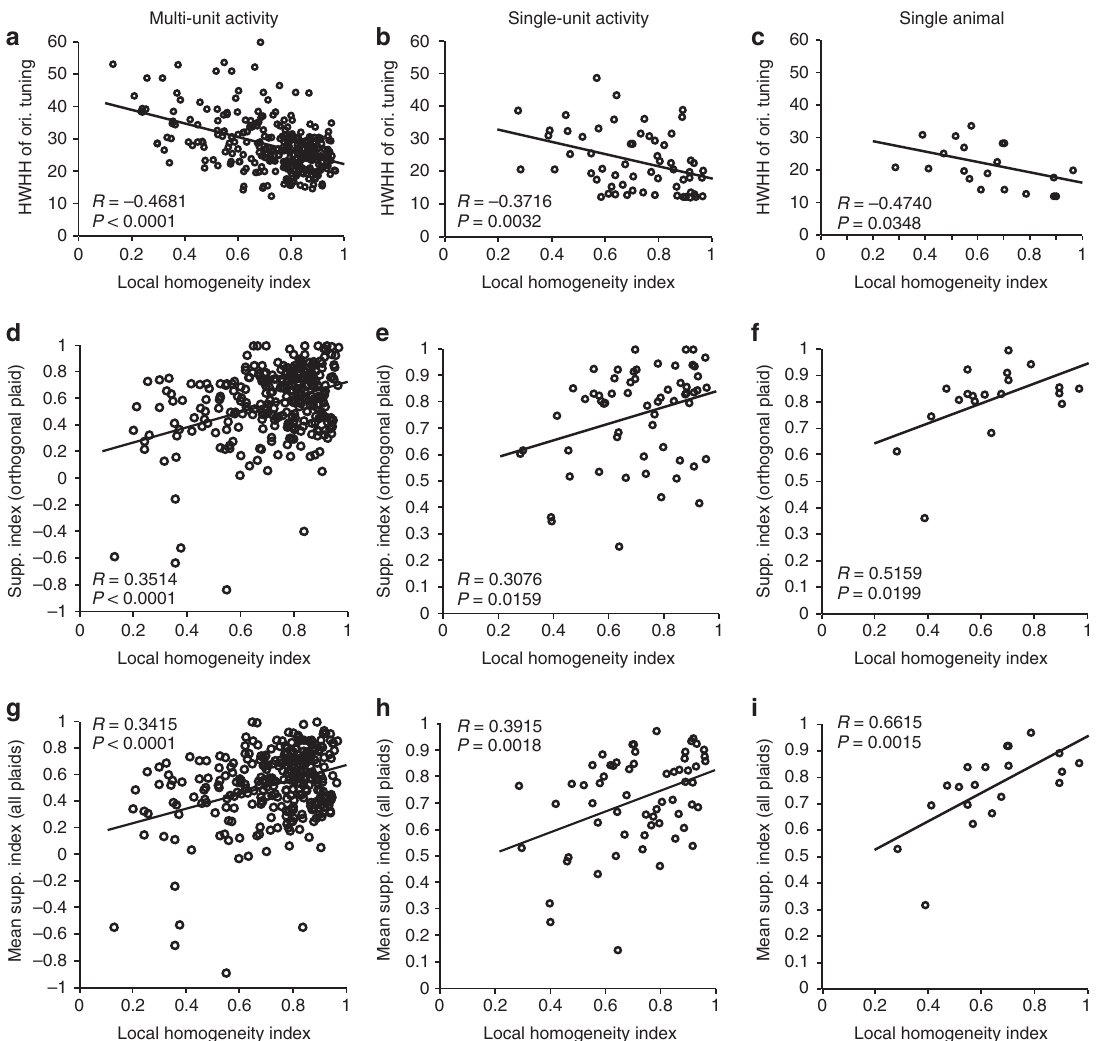
Figure 2 | Association between stimulus orientation and cortical orientation topography. Left column: multi-unit activity ( N ¼ 303; 6 cats). Middle column: single neuron activity ( N ¼ 61; 6 cats). Black lines depict best-fitting linear regression. Right column: single neuron activity for one cat ( N ¼ 20). ( a – c ) Orientation tuning width versus local orientation homogeneity. ( d – f ) SI for the orthogonal plaid (composed of preferred grating and the orthogonal grating) as a function of local orientation homogeneity. ( g – i ) Mean SI (average suppression across all plaids containing the preferred orientation) as a function of the local orientation